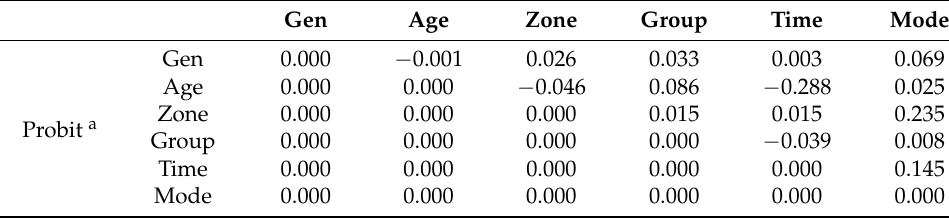
Table 5. Covariation and Relationship of Estimated Parameters.